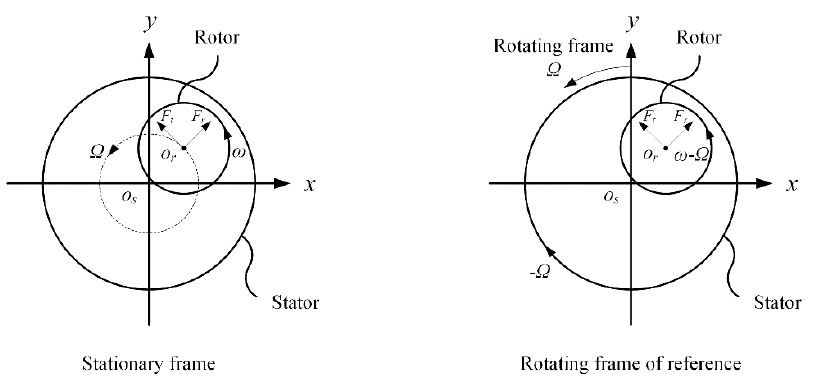
the flow field in the rotating frame of reference.